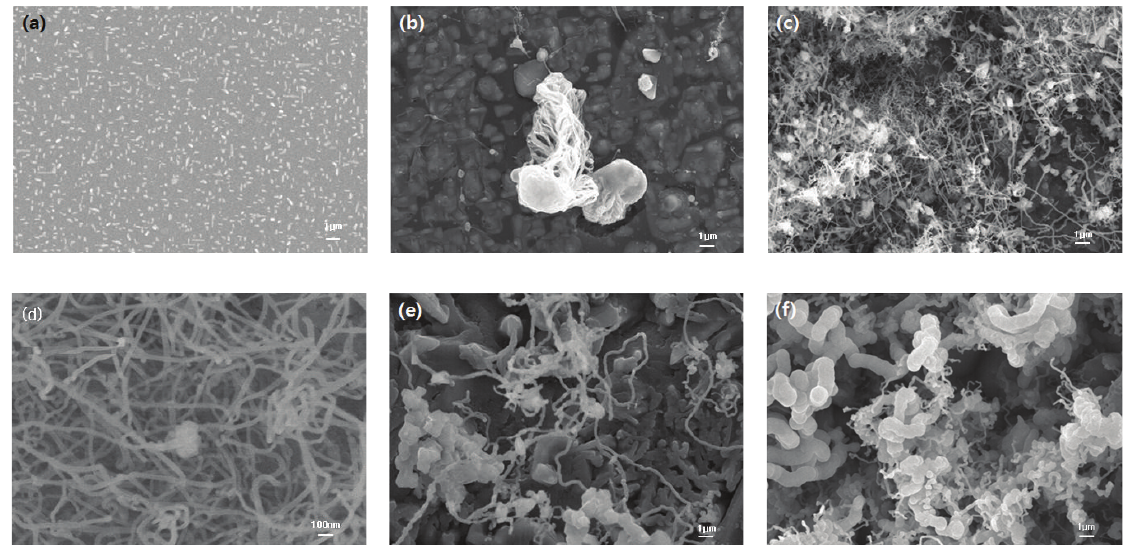
Figure 2: Structural characteristics of GaN:Mn nanowires grown on Si substrates at different temperatures: (a) 1000 ∘ C, (b) 1050 ∘ C, (c) 1100 ∘ C, (d) 1200 ∘ C, (e) 1300 ∘ C and (f) 1400 ∘ C.